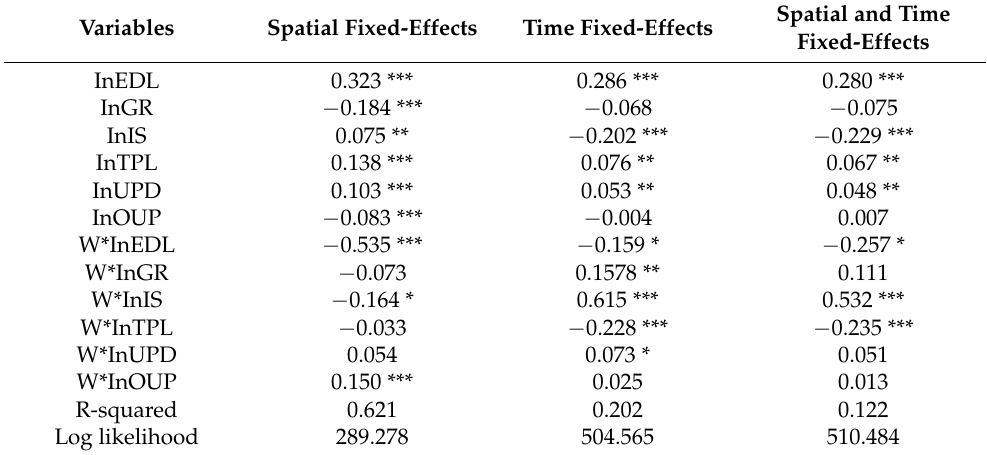
Table 10. The regression results of SDM. Variables Spatial Fixed-Effects Time Fixed-Effects